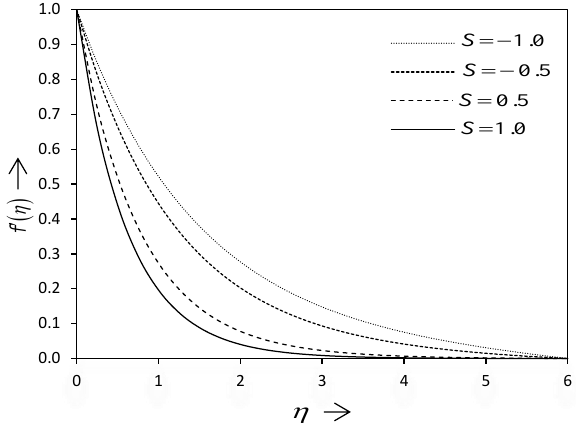
Figure 2. Velocity profiles against  for various values of S with 1.0  A